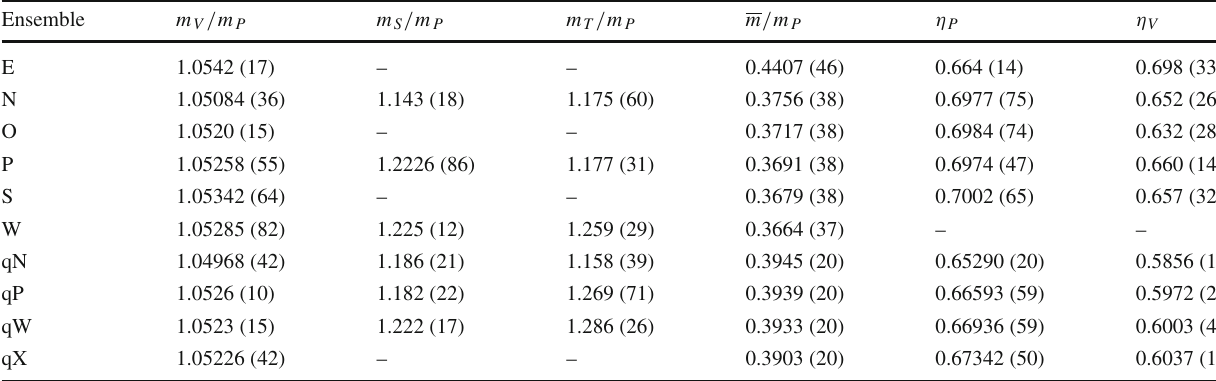
Table 7 Ratios of masses and the mass scaling functions. All values are at the tuning point μ (cid:15)